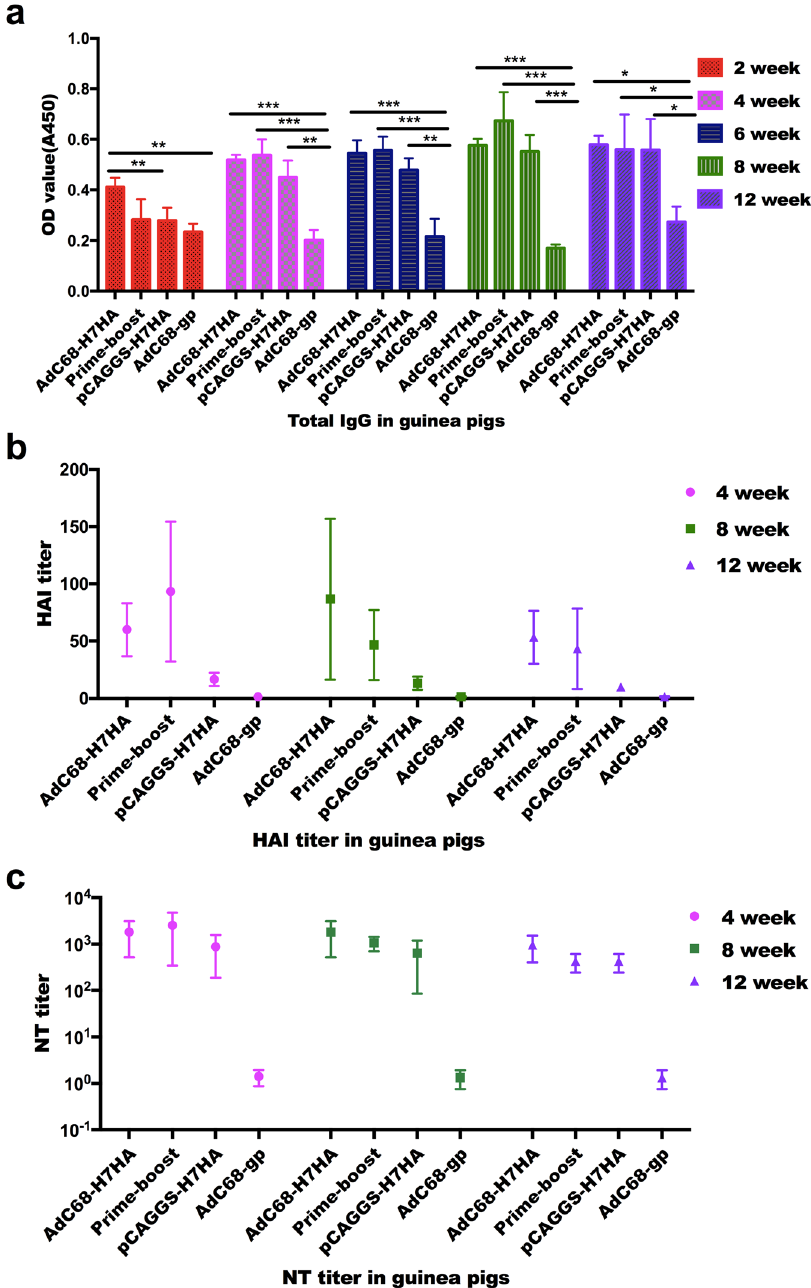
Figure 5. Antibody responses in guinea pigs. Twelve female guinea pigs were divided into 4 groups: the AdC68-H7HA group, the pCAGGS-H7HA group, the AdC68-gp group, and the prime-boost group. Guinea pigs were administered doses double those in mice. Serum samples were collected every 2 weeks for antibody detection. ( a ) Total IgG in guinea pigs taken at different times after immunization. ( b ) HAI titres in guinea pigs at 4, 8, and 12 weeks after immunization. ( c ) NT titres in guinea pigs at 4, 8, and 12 weeks after immunization. *** p < 0.001; ** p < 0.01; * p < 0.05. # At two weeks post immunization, the prime-boost group received DNA priming, as in the DNA-only